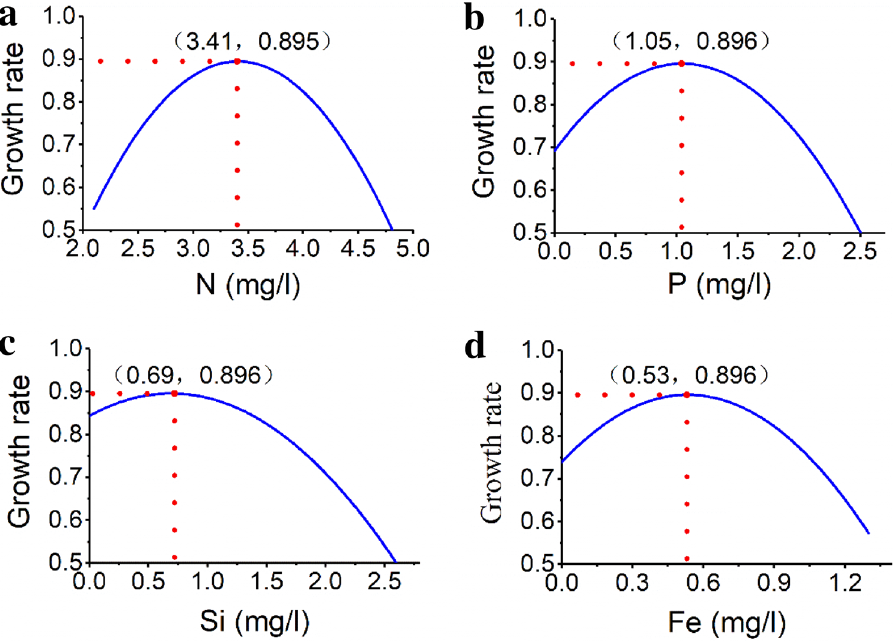
Figure 4. The growth rate of P. parvum as affected by nitrogen ( a ), phosphorus ( b ), silicon ( c ) and iron ( d